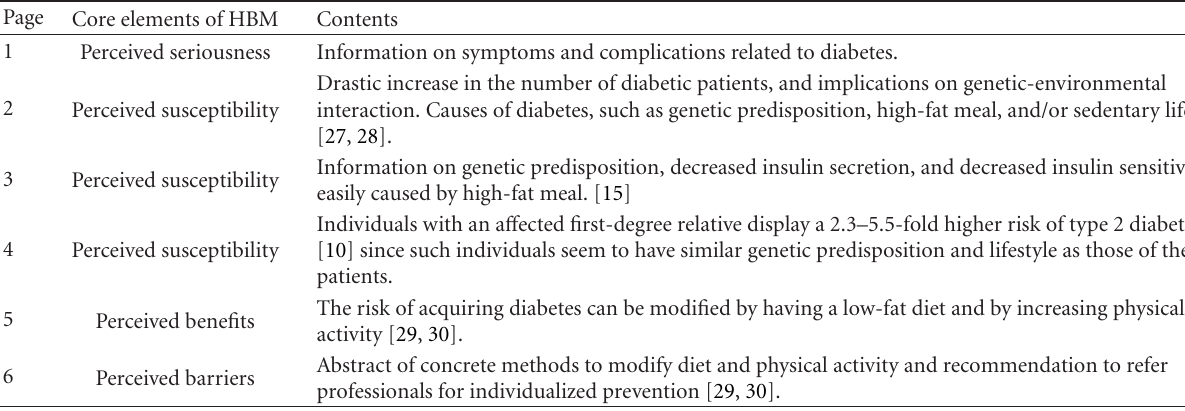
Table 1: Contents of the booklet.